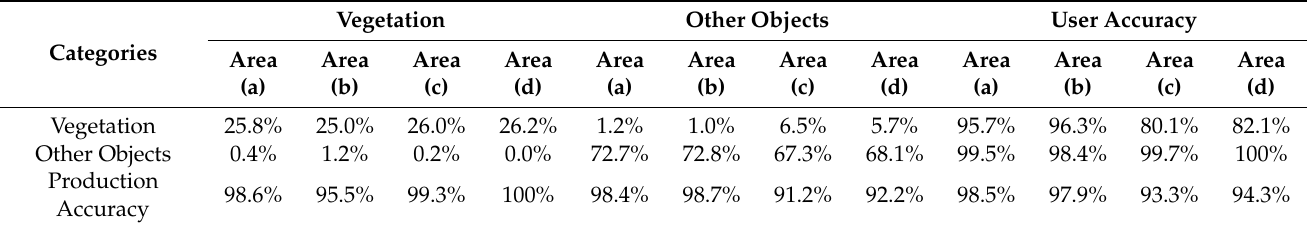
Table 3. Area (a). Table 4. Overall accuracy and Kappa